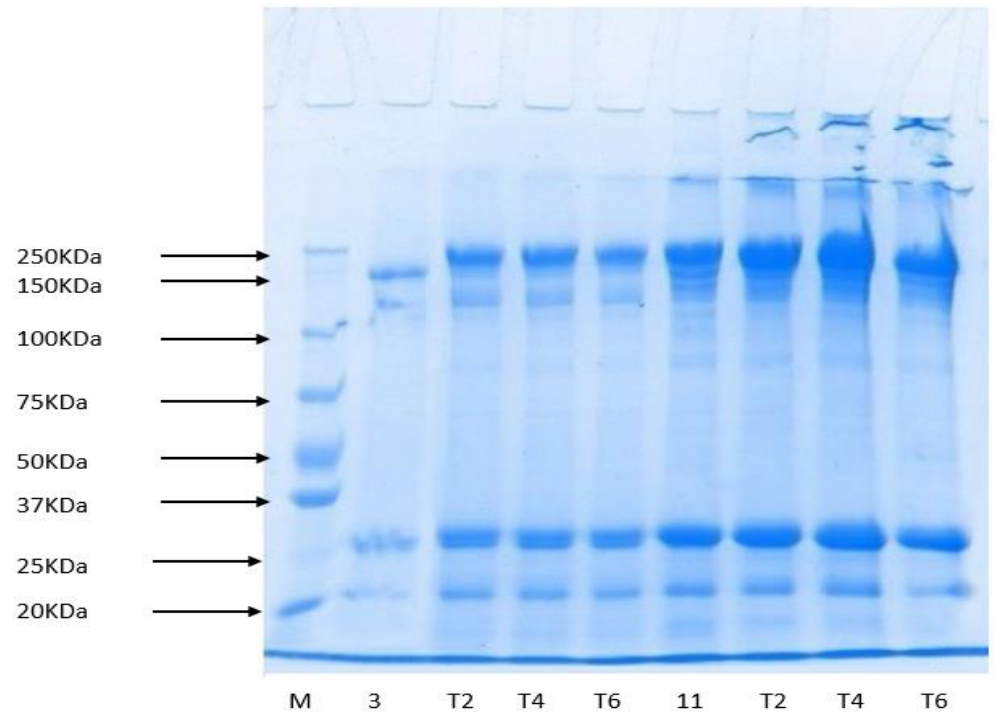
Figure 4. Protein patterns of surimi-based edible films containing different concentrations of green tea extract (GTE) at pH 3 and pH 11. M: Marker, 3: Control with pH 3 and 11: Control with pH 11 (a) T2, T4, and T6: 2%, 4%, and 6% GTE at pH 3 and pH 11.